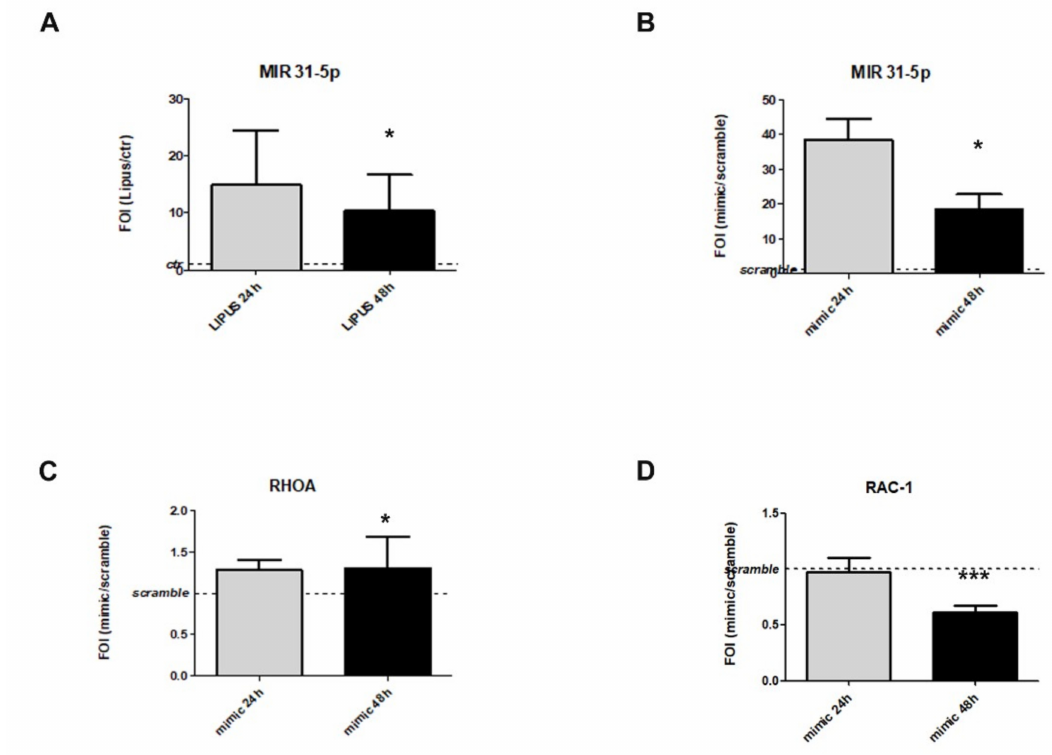
Figure 3. Study of miR-31-5p as a possible target of LIPUS stimulation. Analysis of miR-31-5p expression levels after LIPUS stimulation and after 24 h of miR-31-5p mimic or negative scramble transfection ( A , B ). Analysis of RhoA ( C ) and RAC1 ( D ) expression levels after miRNAs transfection. Quantitative RT-PCR data are expressed as fold of change (FOI) in gene expression (2 − ∆∆ C t ) and occurred in mimic respect to scramble groups. Student’s t test: *, p < 0.05: ***, p < 0.005 between experimental